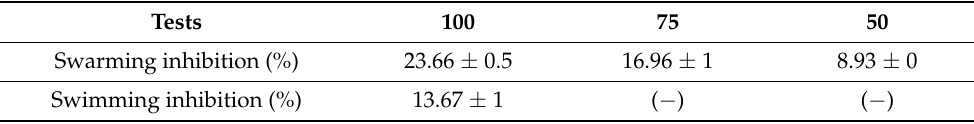
Table 5. Anti-swarming and anti-swimming activities of A. subhirsutum extracts.